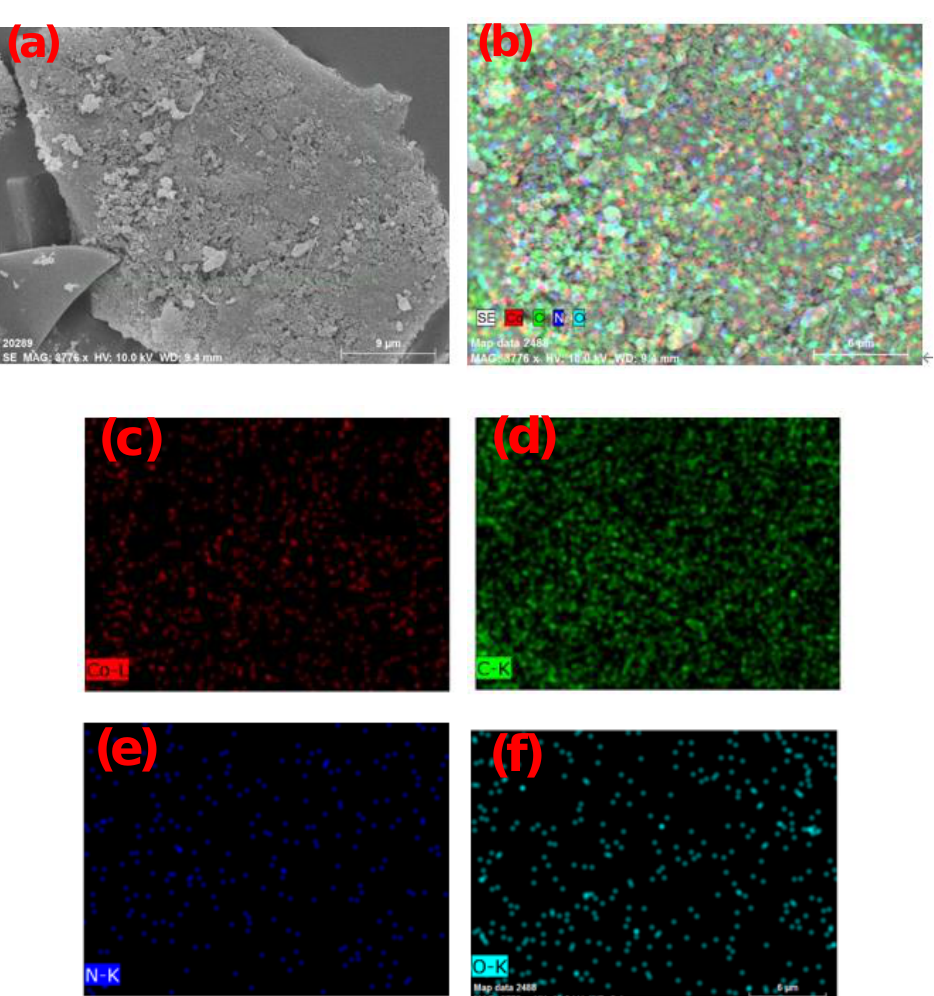
Figure 7. ( a ) SEM picture ( b ) EDs ( c ) cobalt ( d ) carbon ( e ) nitrogen ( f ) oxygen mappings of CoNC- 900A800. Table 2. Compositions of various Co – N – Cs obtained from EDs spectra.